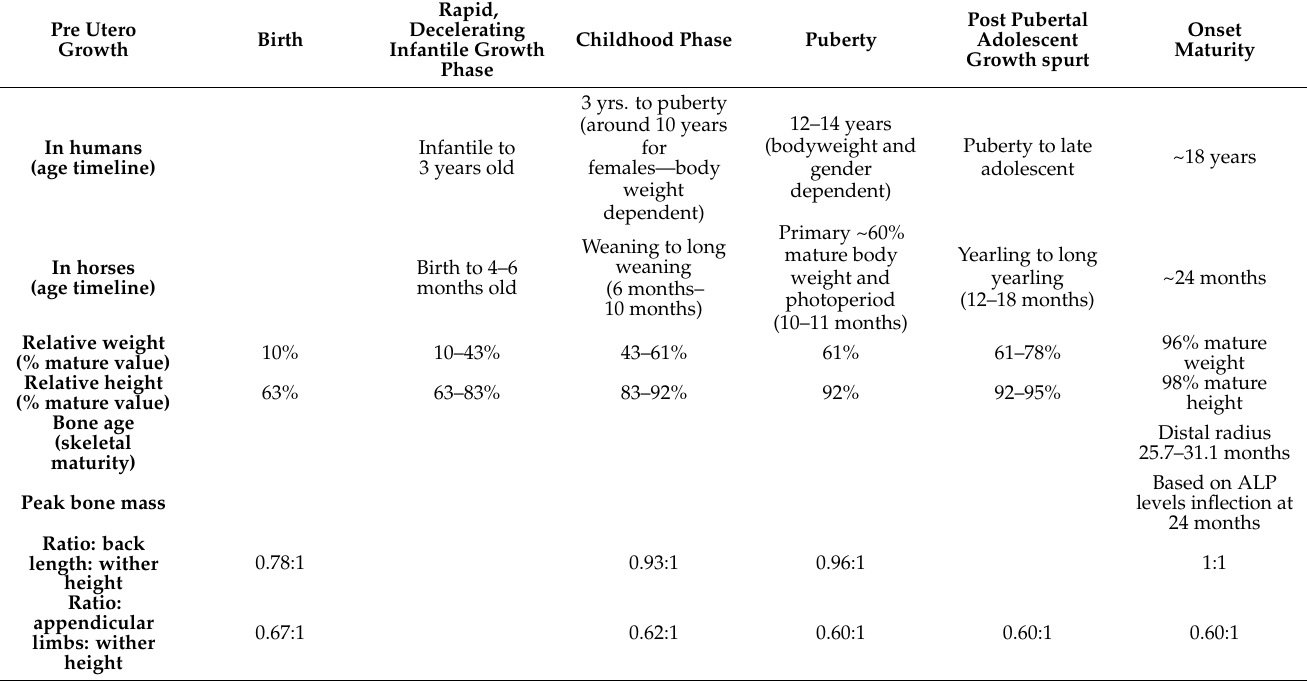
Table 2. Summary of the growth phases used to describe human growth and the relative timing of these in horses with the criteria used to define attainment of these growth or maturity